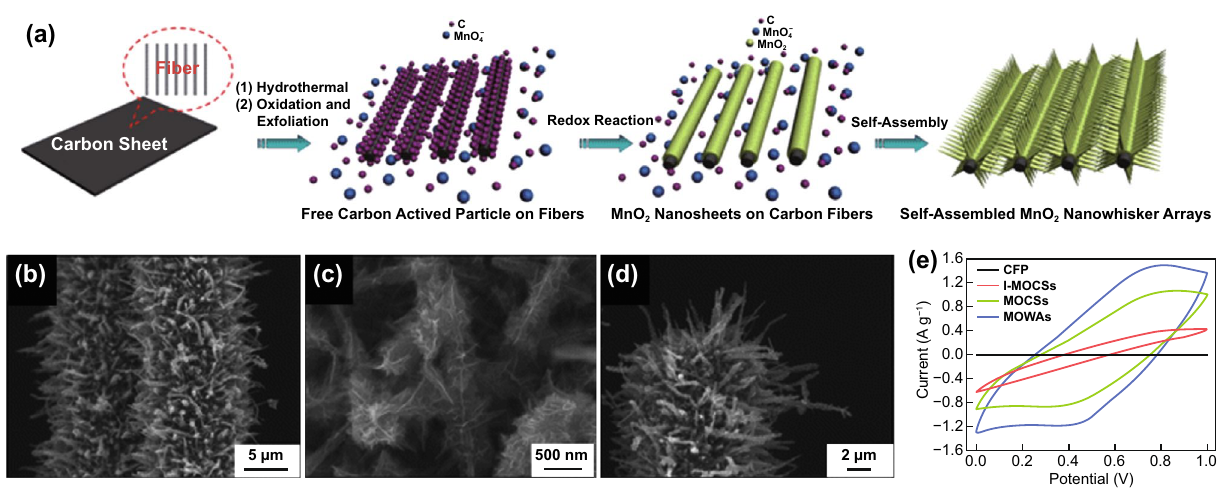
Fig. 6 a Schematic illustration for the formation processes, ( b – d ) SEM images of the MOWAs, and e CV curves of the different electrode mate- rials at 50 mV s −1 . Reproduced with permission from Ref. [122]. Copyright 2012, Royal Society of